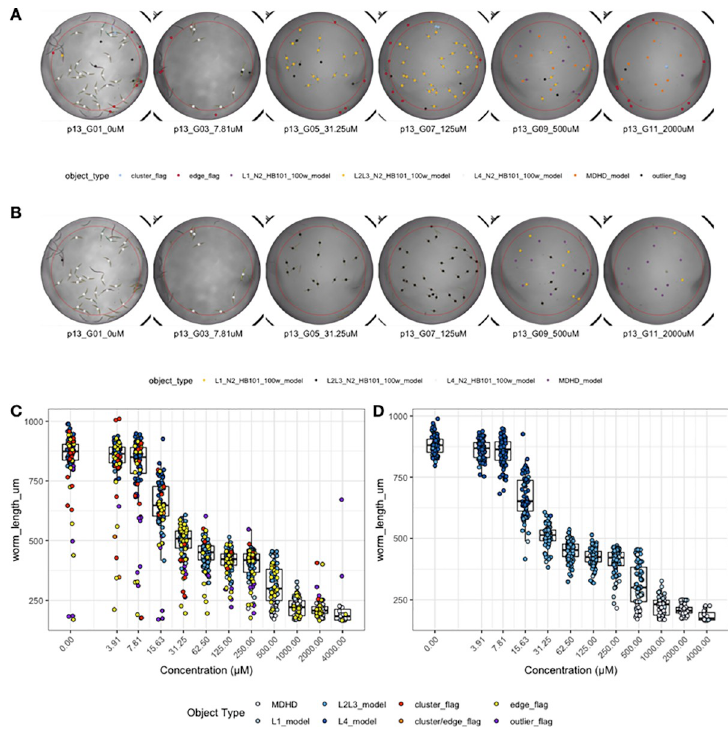
Fig 4. Example plots generated by viewDose() . The function viewDose() plots representative raw (A) or processed (B) well images with objects annotated by model class for each dose of a selected drug and strain. The length measurements of raw (C) and processed (D) are also